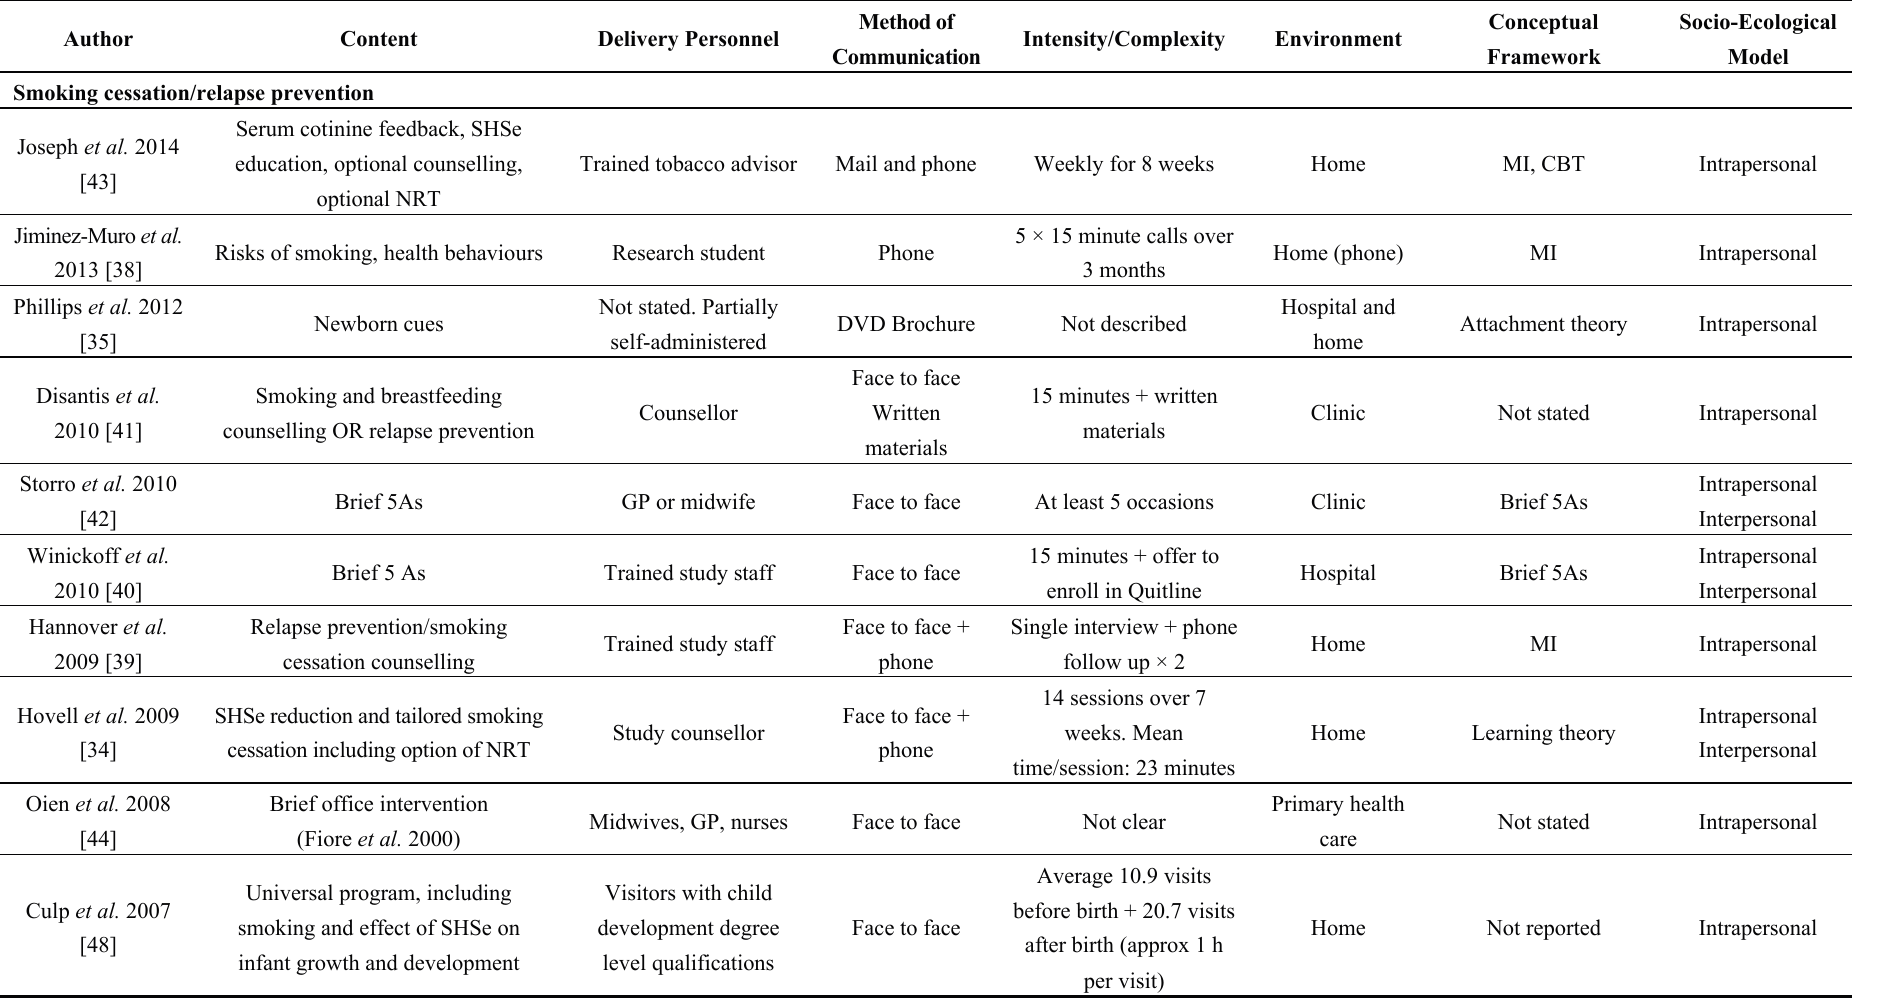
Table 4. Characteristics of